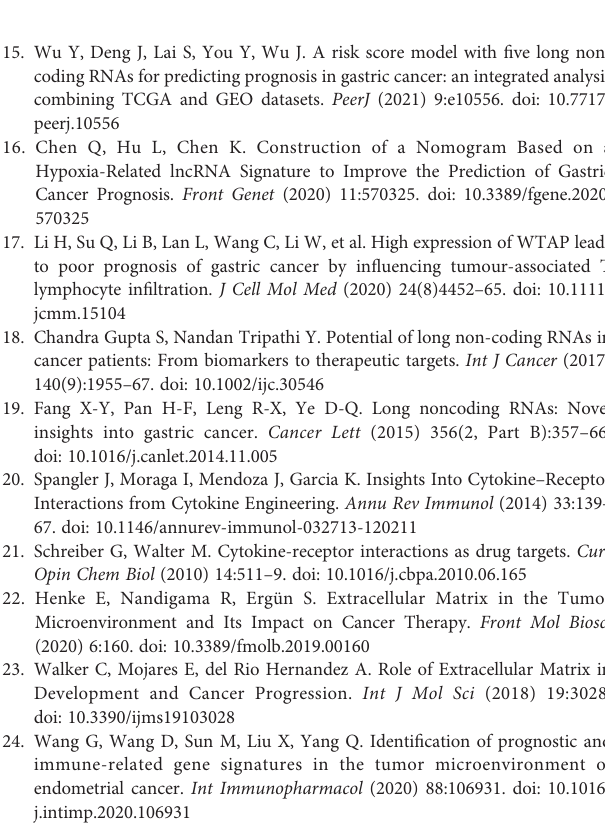
Supplementary Figure 1 | Landscape of 13 m6A RNA methylation regulators. (A) Differentially expressed analysis between tumor and normal tissue of GC among the 13 m6ARNA methylation regulators. (B) correlation analysis ofthe 13 m6ARNA methylation regulators based on the Pearson coef fi cient. Supplementary Figure 2 | Risk score distribution of the m6A-related lncRNA signature in the training dataset (A) and testing dataset (B) , respectively. The upper panel represents the risk score distribution from the low-risk group to the high-risk group. The middle panel represents the cases distribution, and the lower panel represents the expression of each lncRNA in the dataset. Supplementary Figure 3 | Prognostic value of the m6A-related lncRNA signature in DFS. (A) Kaplan-Meier curve analysis between the high-risk group and low-risk group. (B) The receiver operator curve (ROC) analysis for the m6A-related lncRNA signature. Supplementary Figure 4 | A comparison between the reported lncRNA model and our m6A-related lncRNA model through ROC analysis. Supplementary Table 1 | Correlation analysis between m6A-related regulator and all lncRNA. Supplementary Table 2 | Candidate drugs identi fi ed by the CMAP